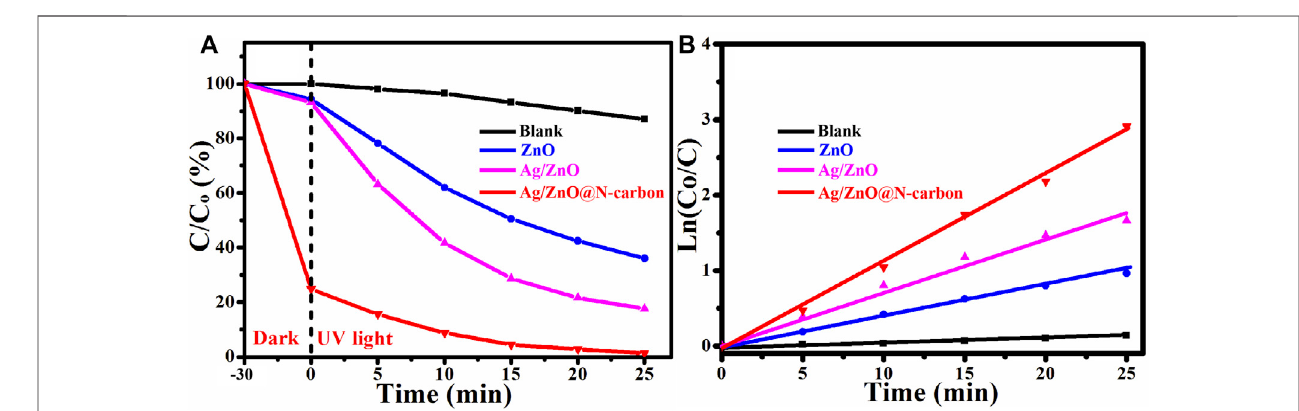
FIGURE 8 | (A) Photocatalytic degradation and (B) the corresponding kinetics of all synthesized sample under UV light.